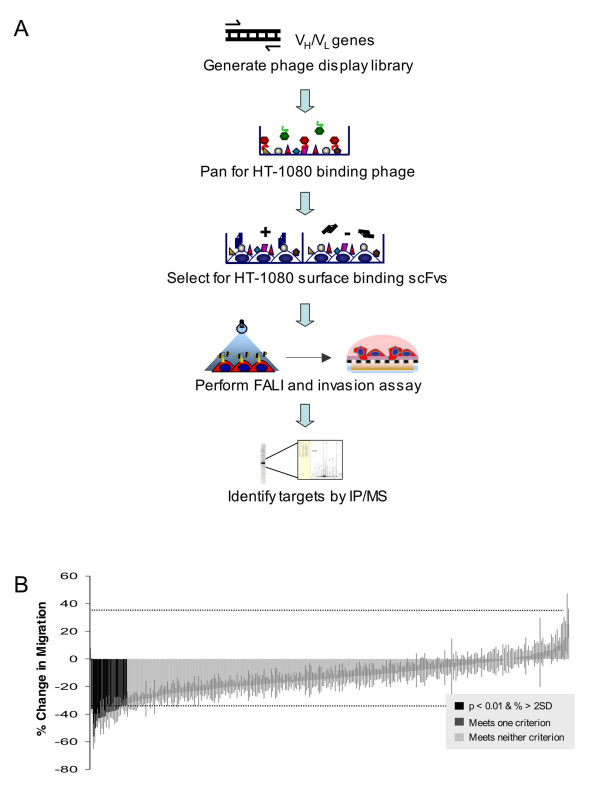
Proteomic screen reveals a role for CD155 in tumor cell invasion. (a) Mice were inoculated with fixed HT1080 cells. A phage display library was generated from immunoglobulin genes (VH and VL) to generate recombinant scFvs (107 phage). Phage were immunopanned against HT1080 cells, and 2,760 binders were isolated. 595 of the resulting scFvs were further selected as HT1080 surface binders. These surface binders were conjugated to FITC and used to inactivate their protein targets by fluorophore-assisted light inactivation (FALI). The invasiveness of FALI- and control-treated cells was then compared using a high-throughput transwell assay in which cells were challenged to invade through a matrigel-coated 8βM filter towards a serum chemoattactant. Protein targets of candidate scFvs were identified by immunoprecipitation and mass spectrometry. (b) 338 scFvs were screened in triplicate in two independent experiments using the FALI-invasion assay. 6 scFvs caused a significant reduction of HT1080 invasion compared to non-FALI controls (p < 0.01, unpaired t-test and an amplitude change of greater than twice the average standard deviation).